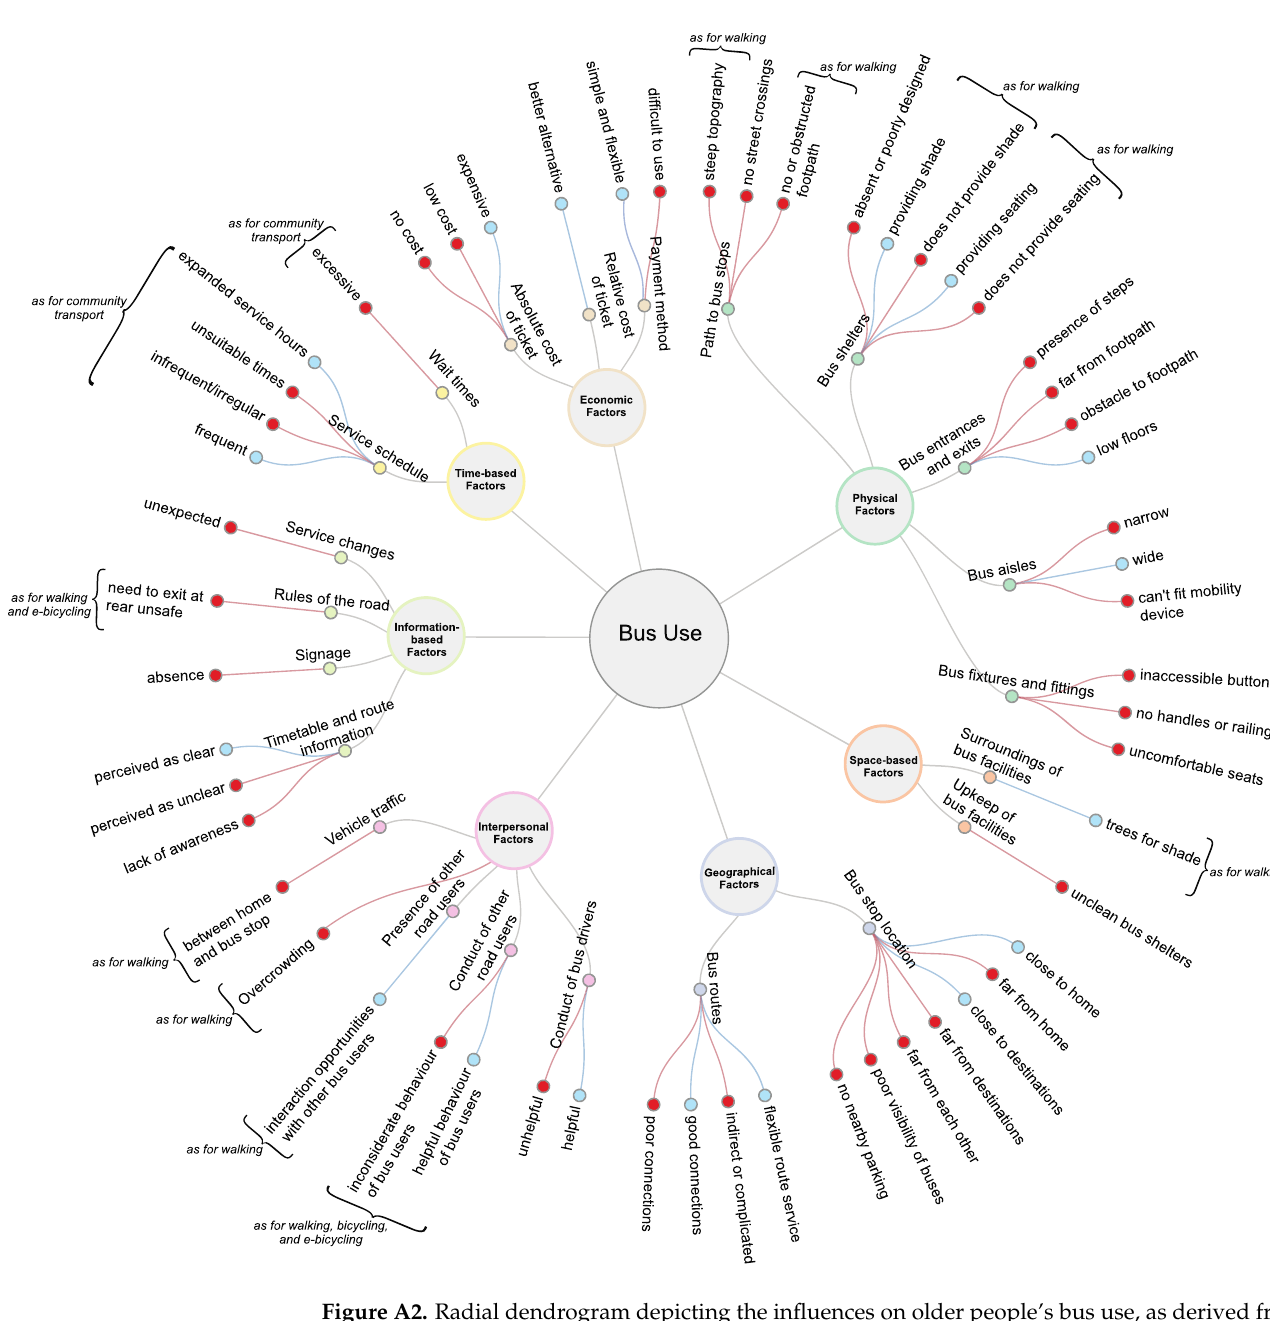
Figure A2. Radial dendrogram depicting the influences on older people’s bus use, as derived from 11 articles.